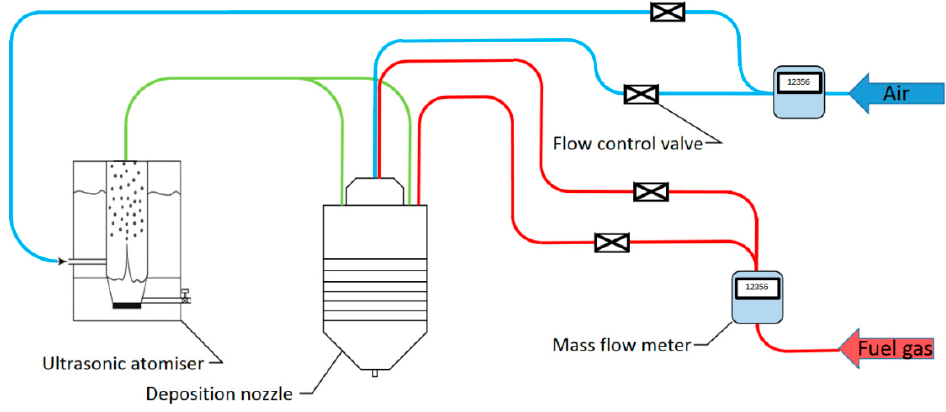
Figure 2. A schematic of the nanoparticle coating system based on flame-assisted spray pyrolysis.